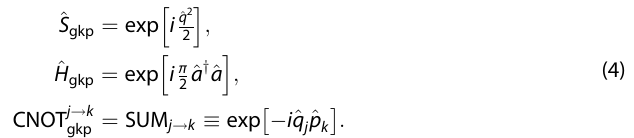
(cid:3) (cid:4) (cid:3) with an